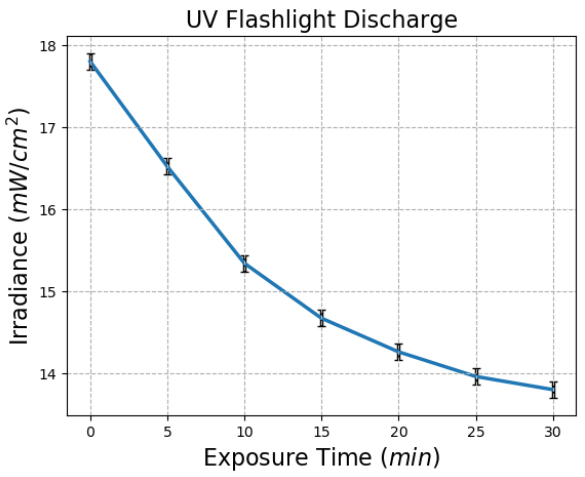
Figure 10. Power drop of UV flashlight as a function of